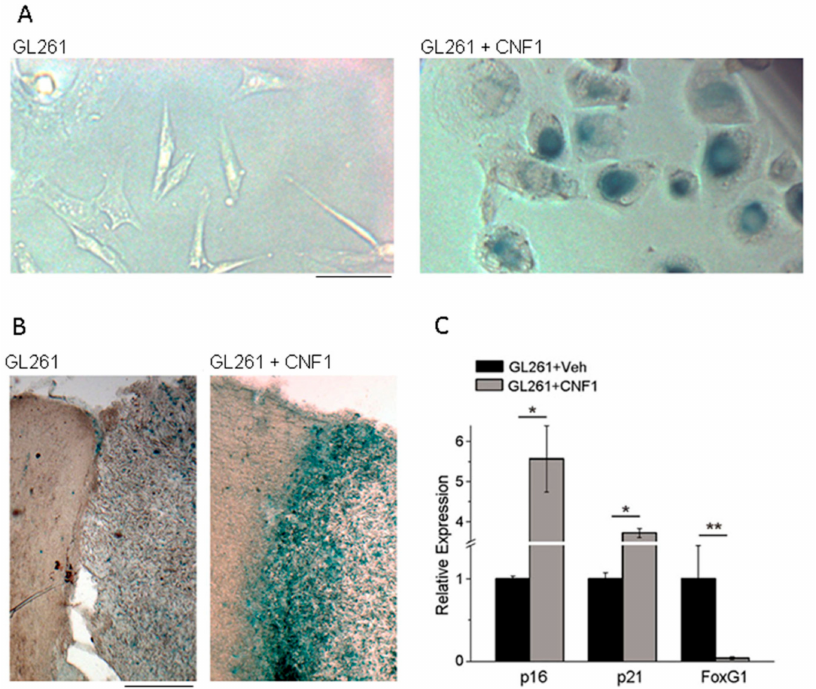
Figure 2. CNF1 treatment triggers senescence of glioma cells. ( A ) β -galactosidase staining (blue; a marker for senescence) in cultured GL261 glioma cells treated with either vehicle ( left ) or CNF1 ( right ). Note multinucleated, senescent cells after CNF1 treatment; ( B ) Representative brain sections from glioma-bearing mice treated with either vehicle ( left ) or CNF1 ( right ). Note robust staining for β -galactosidase (blue) in the CNF1-treated sample. Scale bar = 10 µ m for ( A ), 100 µ m for ( B ); ( C ) Quantitative real-time PCRs showing the relative expressions of the senescence markers p21 (Cdkn1a, Cyclin-dependent kinase inhibitor 1) and p16 (Cdkn2a, Cyclin-dependent kinase inhibitor 2), and the negative p21 regulator FoxG1 (Forkhead box protein G1) in GL261 cells treated with CNF1 or vehicle. * p < 0.05, ** p < 0.01. Panel B modified and C taken from Vannini et al., 2016